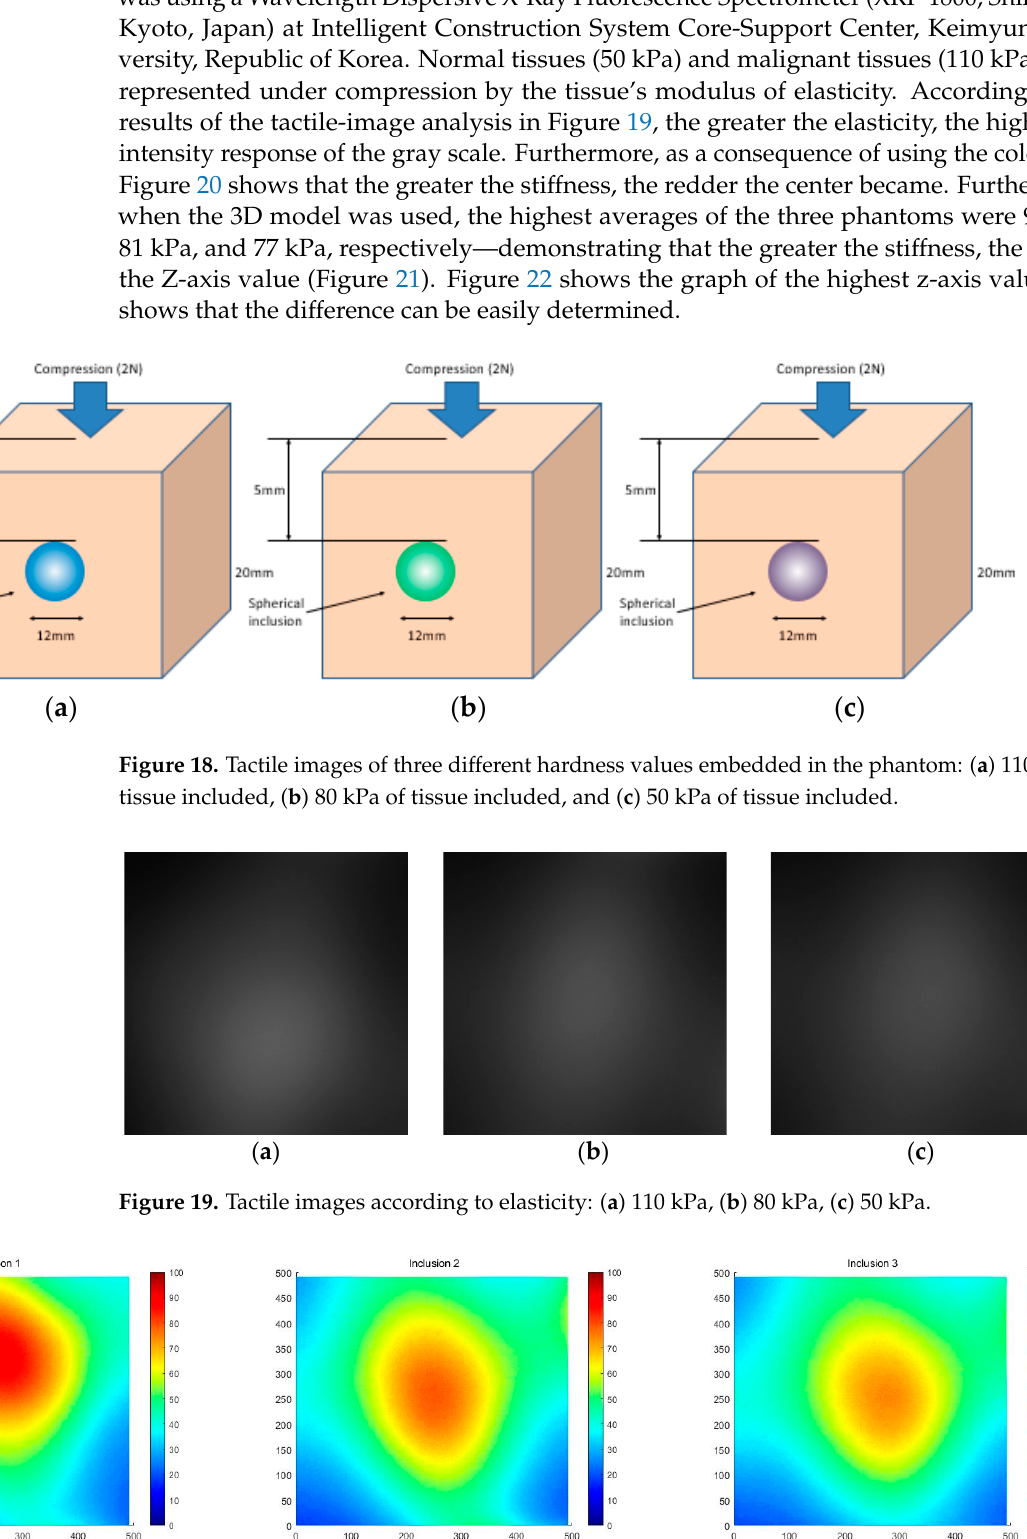
Figure 20. Two-dimensional colormap simulations according to elasticity: ( a ) 110 kPa, ( b ) 80 kPa, ( c ) 50 kPa.